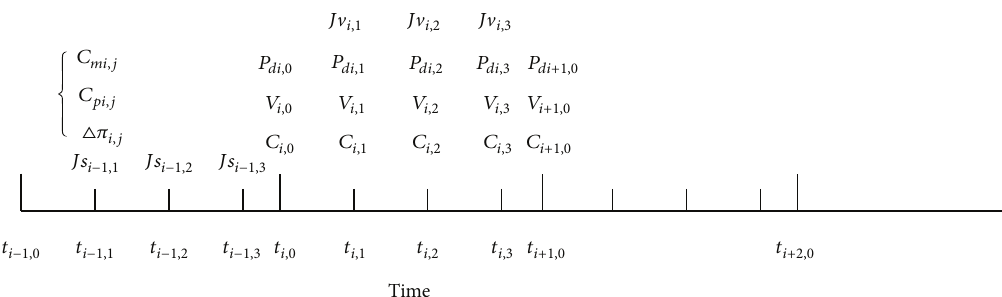
Figure 3: Discretization by collocation on finite